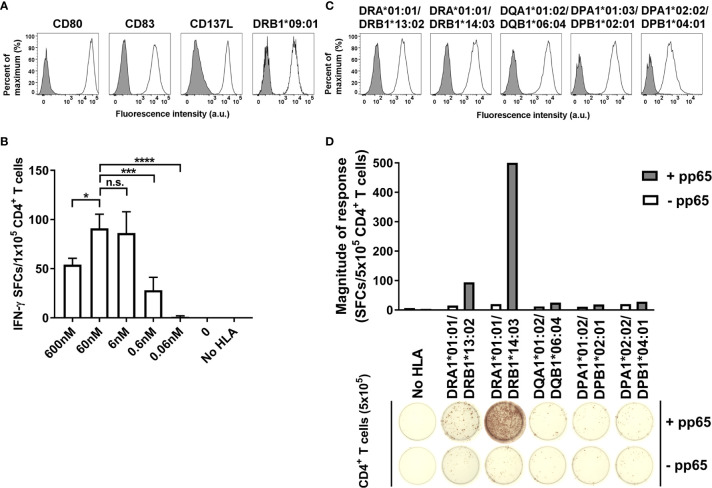
Optimization of artificial antigen-specific CD4+ T cells restricted by single HLA class II allotype. (A) K562 was transduced with CD80, CD83, CD137L, and DRA*01:01/DRB1*09:01 and purified by FACS to generate aAPC. (B) 1×105 CD4+ T cells of HD21 were stimulated with 1×104 aAPC loaded with cytomegalovirus (CMV) pp65 peptide pool at a concentration of 600 nM, 60 nM, 6 nM, 0.6 nM, or 0.06 nM, respectively. Data is presented as mean ± SDs of triplicates. n.s., not significant; *P < 0.05, ***P < 0.001, ****P < 0.0001 by one-way ANOVA. (C) Representative membrane expression of HLA-DR, -DQ, and -DP molecules on aAPCs expressed by HD09. (D) Representative IFN-γ ELISPOT assay of CD4+ T cells cocultured with aAPCs stably transduced with nothing (No HLA), or the HLA-DR, -DQ, and -DP alleles expressed by HD09 pulsed with nothing (-pp65) or CMV pp65 (+pp65).